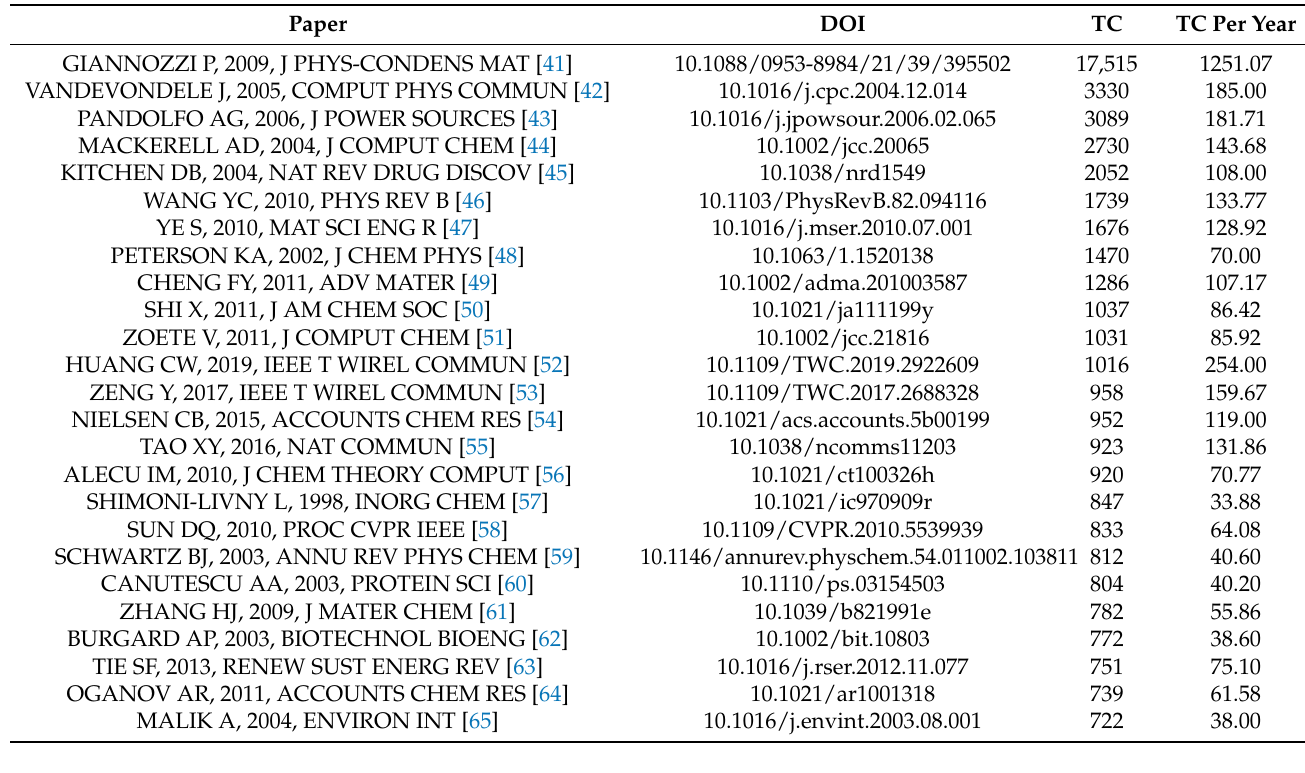
Table 4. Most of the top 25 globally cited papers.